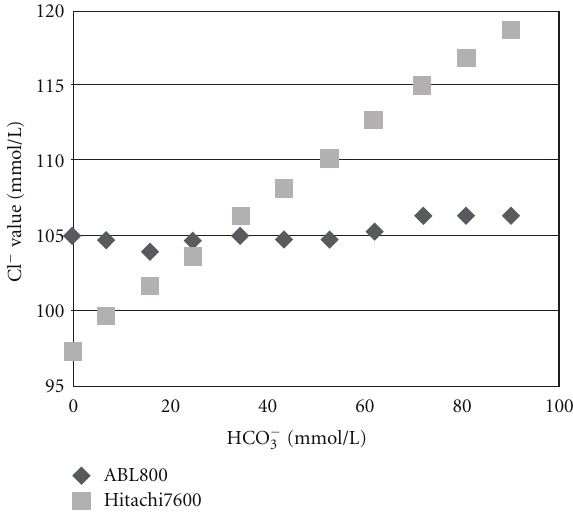
Figure 3: Interference of bicarbonate (HCO 3 − ) concentrations on chloride (Cl − ) concentrations measured with a Hitachi7600 or an ABL800. There was a concentration-dependent increase in Cl − concentrations measured with the Hitachi7600 (i.e., the mean concentrations were statistically di ff erent from each other) but not with the ABL800, with increasing HCO 3 − concentrations. Data are